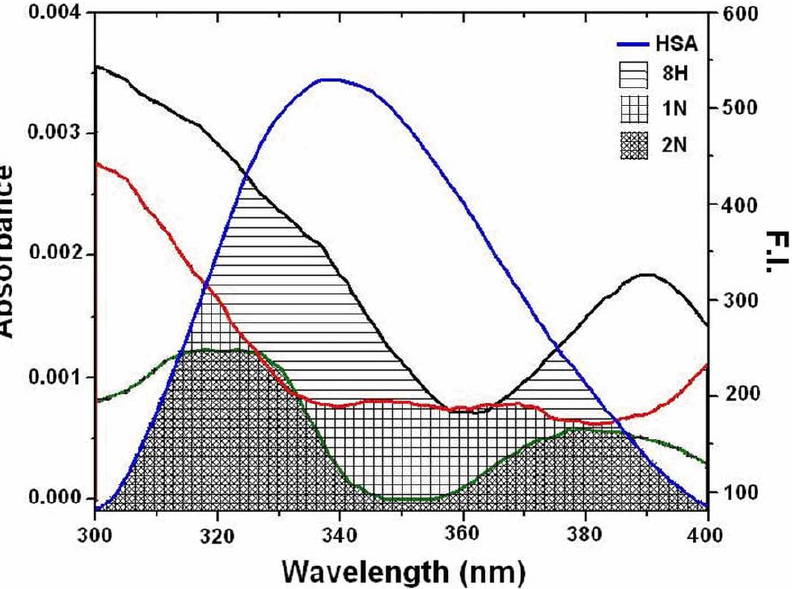
Figure 7. Tryptophan fluorescence resonance energy transfer. Spectral overlap of the fluorescence emission of HSA ( l ex =295 nm) and absorption spectra of pollutants [HSA=Pollutants=2 m